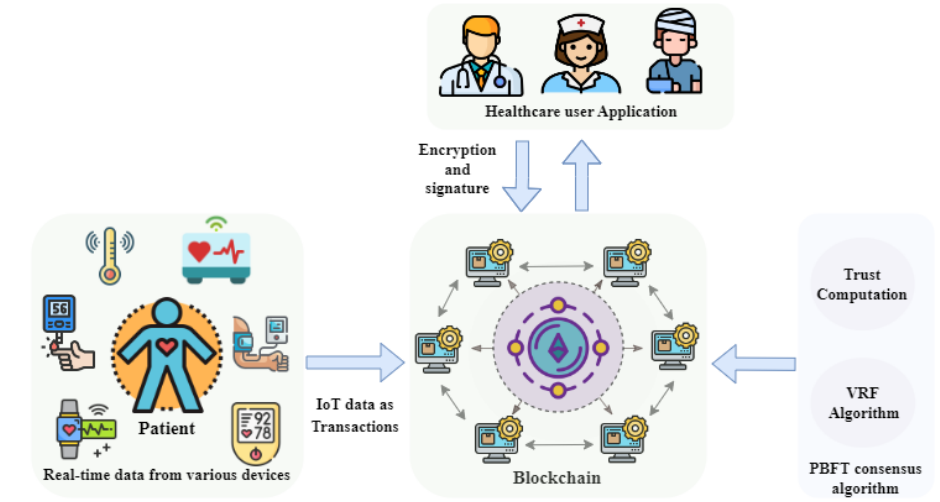
Figure 5. Architecture of the identified healthcare use-case to demonstrate the proposed